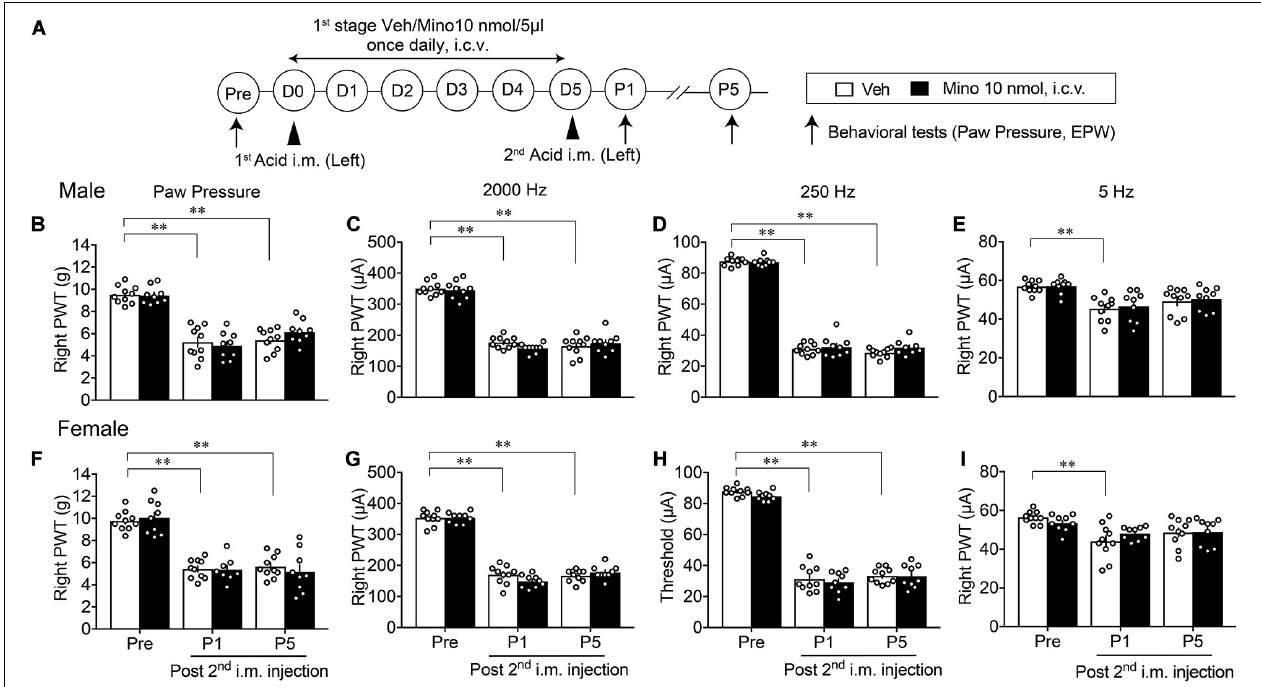
FIGURE 3 | Lack of effects by early treatments with brain minocycline on the AcGP in male and female mice. (A) Minocycline dissolved in 10 nmol/5 µ l of aCSF or aCSF (as a vehicle, Veh) was administered (i.c.v.) once daily from D0 to D5, as the 1st-stage treatments. Behavioral tests represent the paw pressure test and EPW test using 2,000, 250, and 5 Hz electrical stimulation (B–I) Sexual dimorphic effects by 1st stage of minocycline treatments (D0–D5) on the abnormal pain behaviors induced by acid saline into the left muscle. Results represent the nociceptive threshold (g) on the right side at indicated time points (arrows) in the paw pressure test (B,F) and the threshold ( µ A) in the EPW test using 2000 Hz (C,G) , 250 Hz (D,H) , and 5 Hz (E,I) , respectively, in male (B–E) and female (F–I) mice. ∗∗ p < 0.01, compared with Pre, in two-way repeated measures ANOVA followed by Dunnett’s multiple comparisons test (Veh, n = 10; Male Mino, n = 9; Female Mino, n = 8–9). The dots in the column represent number of animals. AcGP, acid saline-induced FM-like generalized pain; Mino, minocycline; and PWT, paw withdrawal threshold.